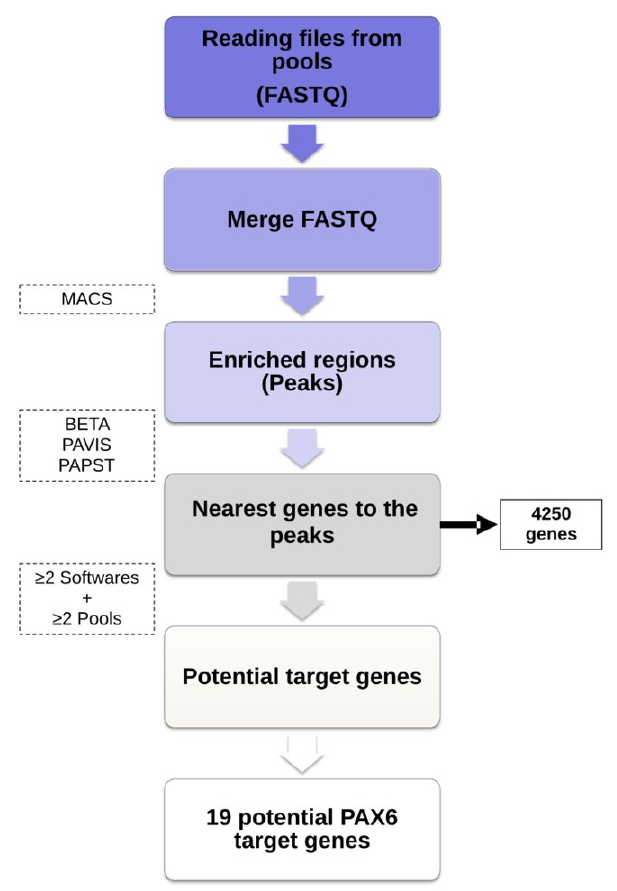
Figure 4. Diagram that shows the methodological approach used for the selection of PAX6 target